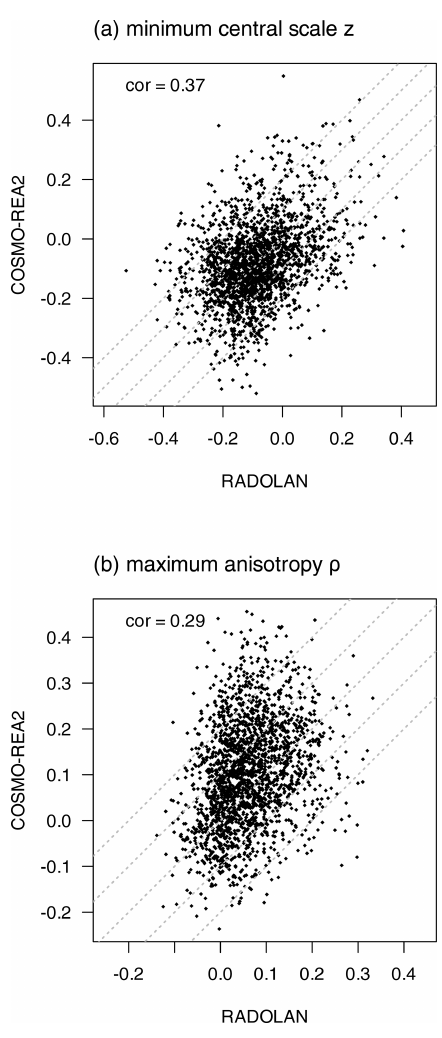
Figure 11. Scatterplot of daytime minimum scale (a) and day- time maximum anisotropy (b) anomalies during daytime in sum- mer (JJA) from RADOLAN ( x axis) and COSMO-REA2 ( y axis). Anomalies were calculated by subtracting the respective mean val- ues from every hour of the day. Dashed lines mark errors d z, d ρ = {− 0 . 2 , − 0 . 1 , 0 , 0 . 1 , 0 . 2 }